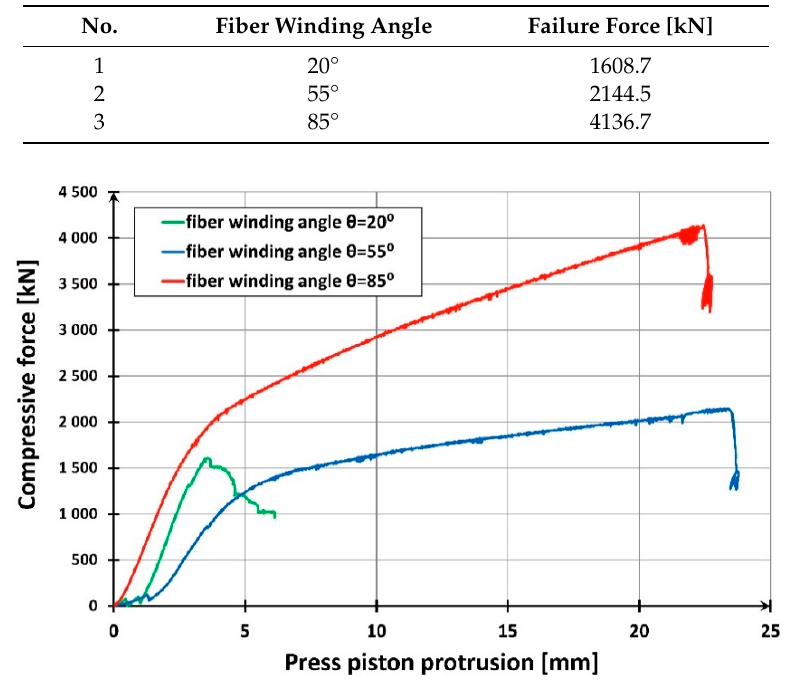
Figure 12. Force-displacement relationship for test specimens made from a 40-cm-long composite pipe filled with concrete.